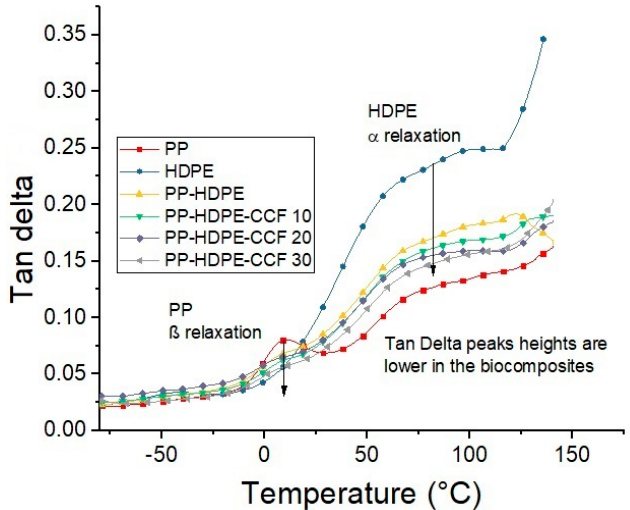
Figure11. Figure 11. Temperature dependence of tan delta of neat PP, HDPE, PP-HDPE blend, and their biocomposites.